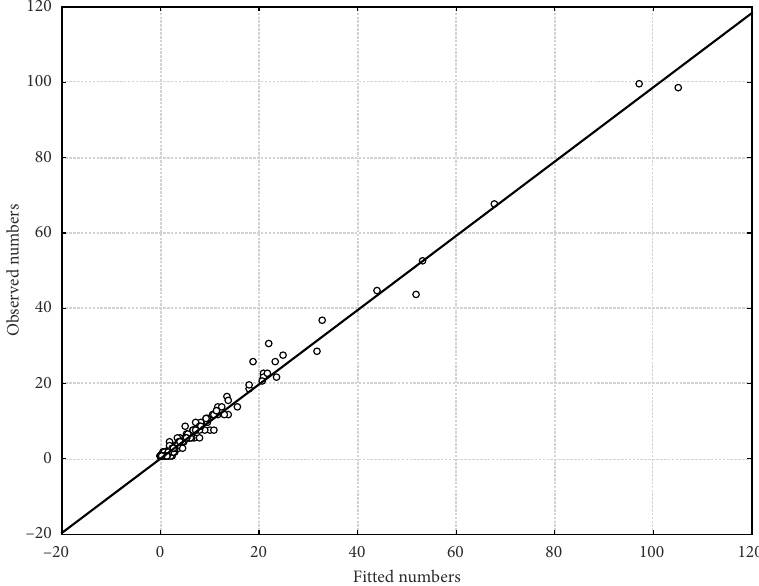
Figure 2. Distribution graph of observed frequencies versus fitted frequencies